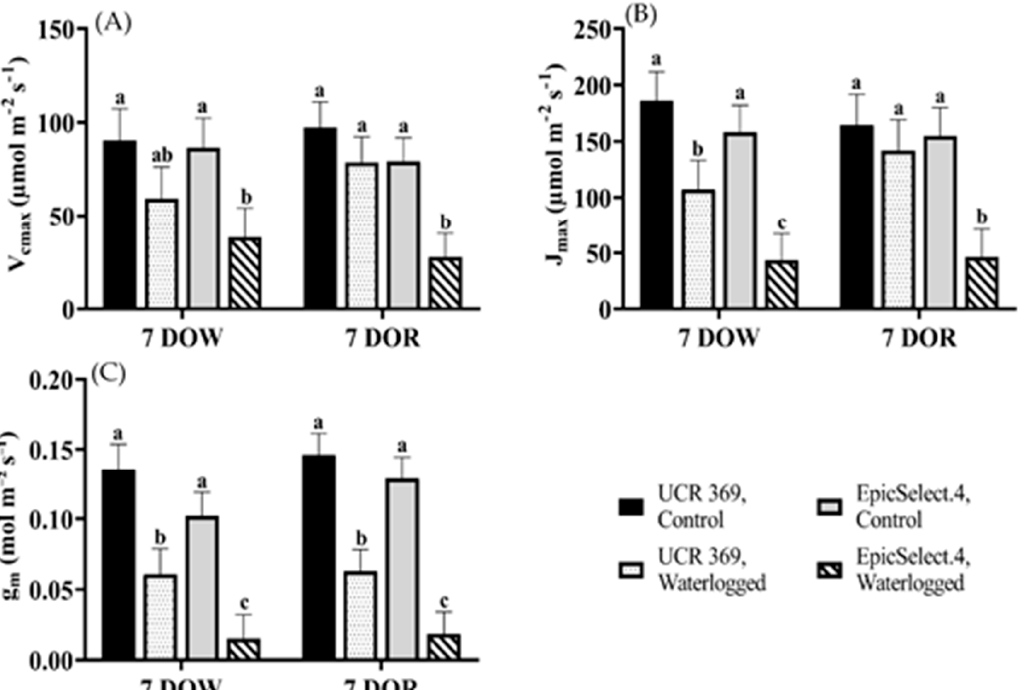
Figure 3. ( A ) Maximum rate of Rubisco carboxylation (V cmax ), ( B ) Maximum rate of photosynthetic electron transport (J max ), ( C ) Mesophyll conductance (g m ) of control and waterlogged cowpea genotypes (UCR 369 and EpicSelect.4) after 7 days of waterlogging (DOW) and 7 days of recovery (DOR). Different lowercase letters indicate significant differences between genotype’s means and treatments ( p < 0.05), as determined by Fisher’s LSD. The error bar on the vertical bar indicates the standard error of the mean ± 4 replications of each leaf gas exchange trait. Standard error of the mean at 7 DOW, V cmax = 17.00; J max = 25.80; g m = 0.018; and at 7 DOR V cmax = 13.70, J max = 27.40, g m = 0.015.